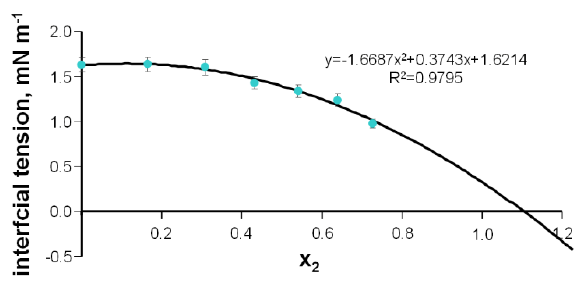
Figure 4. Hypothetical interfacial tension data for diosgenin bilayer.